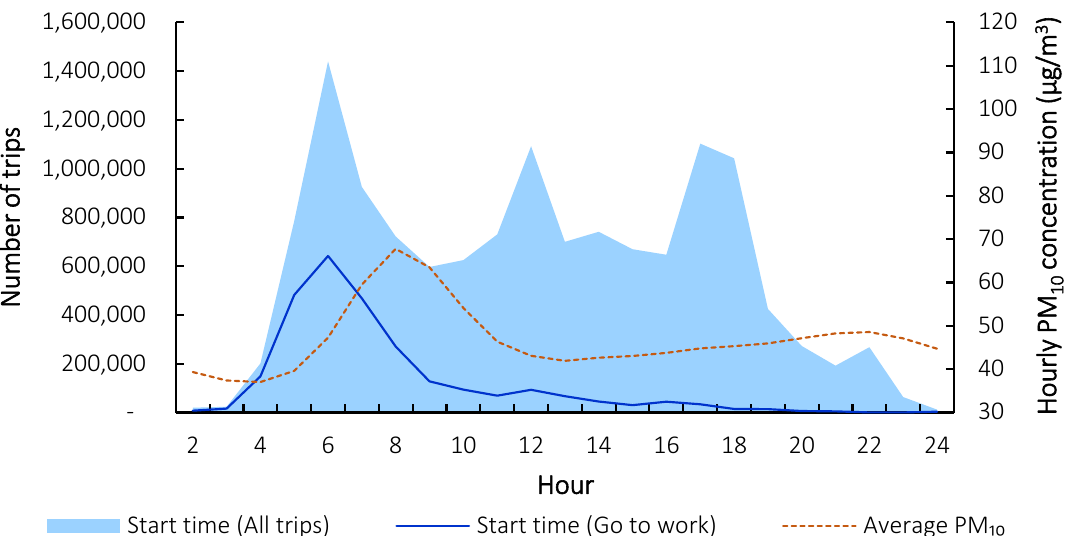
Figure 3. Behavior of the hourly PM 10 concentration in relation to the hourly amount of motor vehicle trips in Bogotá D.C.